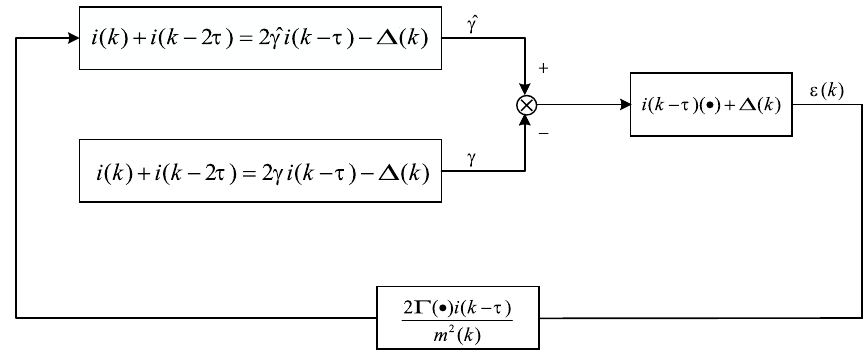
Figure 2. Block diagram of the robust frequency